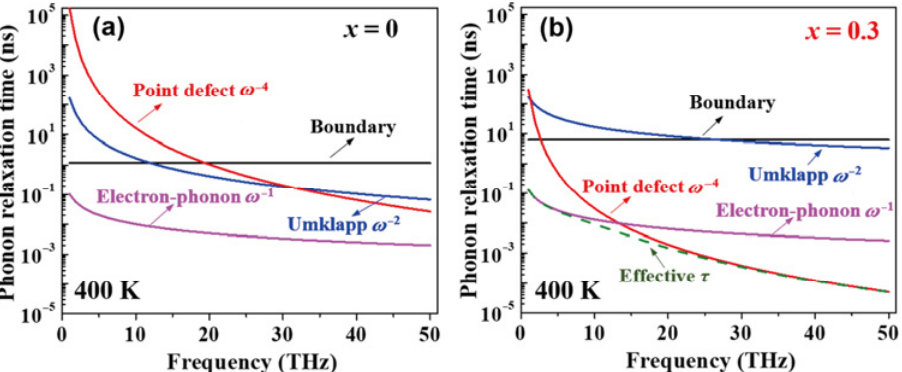
Fig. 9 Calculated phonon relaxation time ( τ ) vs. frequency ( ω ) for CeFe 3.8 − x Ni x Co 0.2 Sb 12 samples at 400 K: (a) x = 0, (b) x =